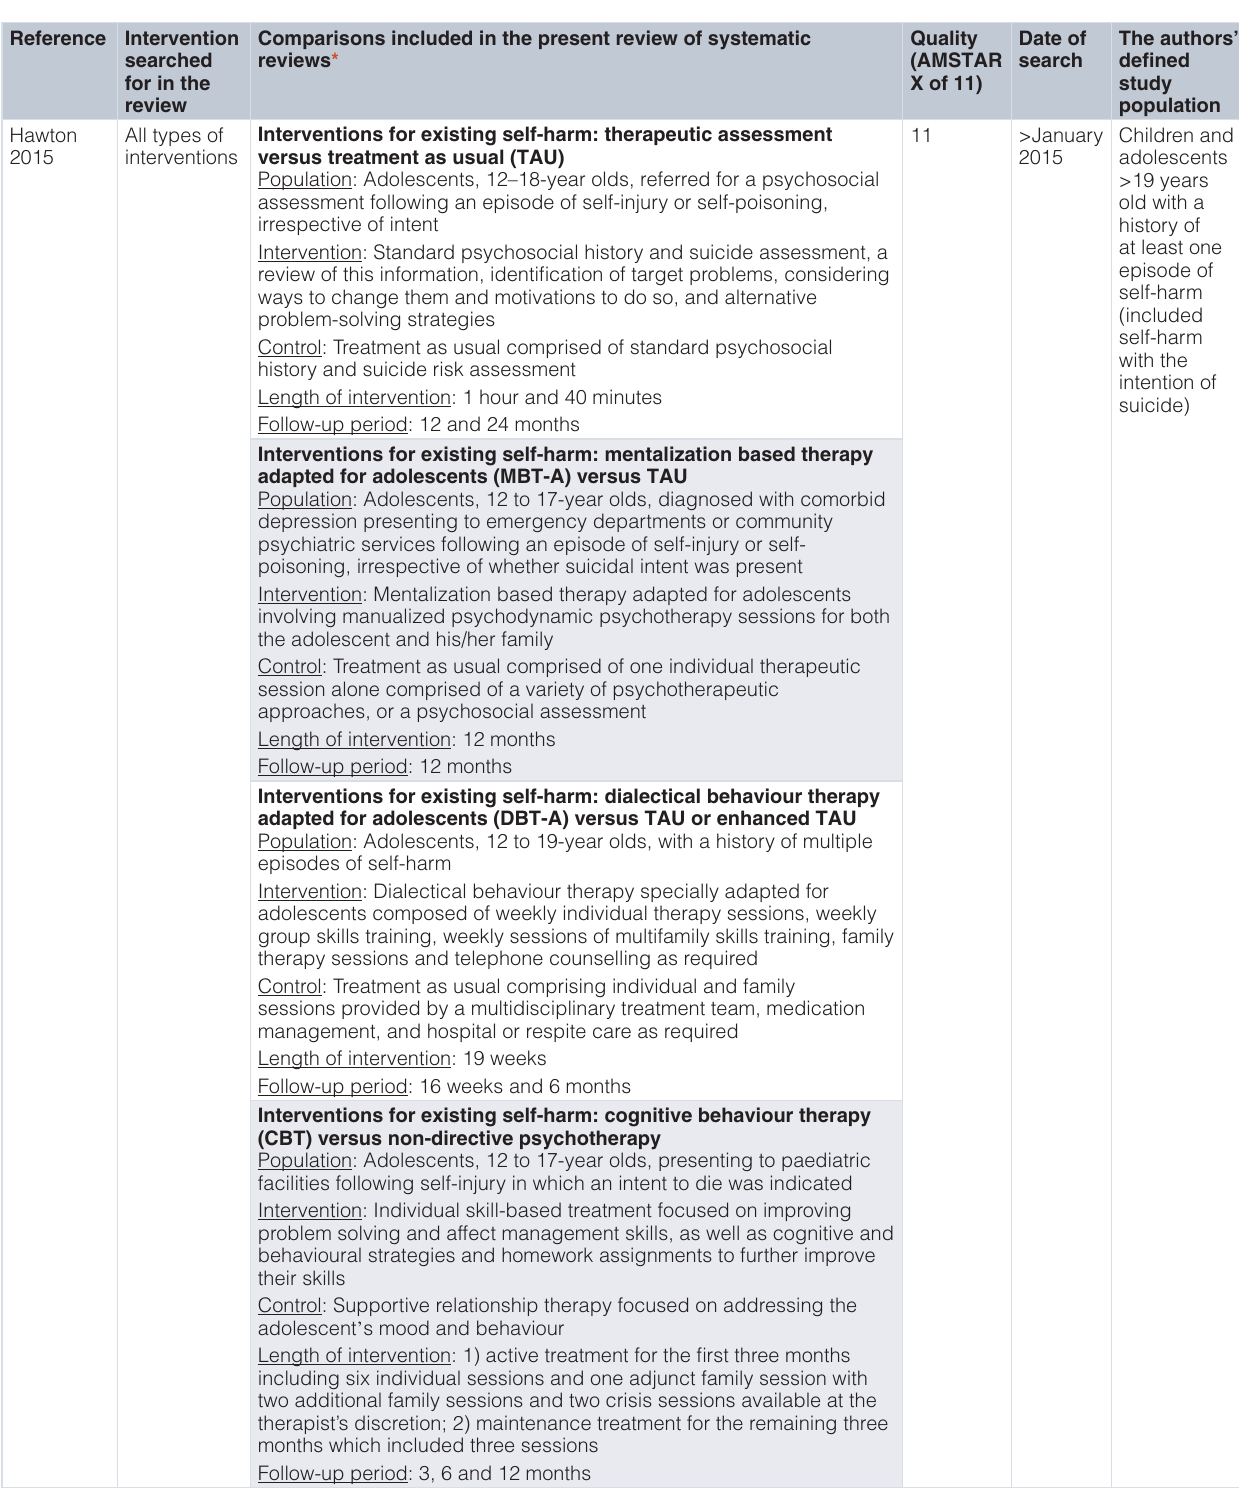
Table 1. Characteristics and methodological quality of the included systematic